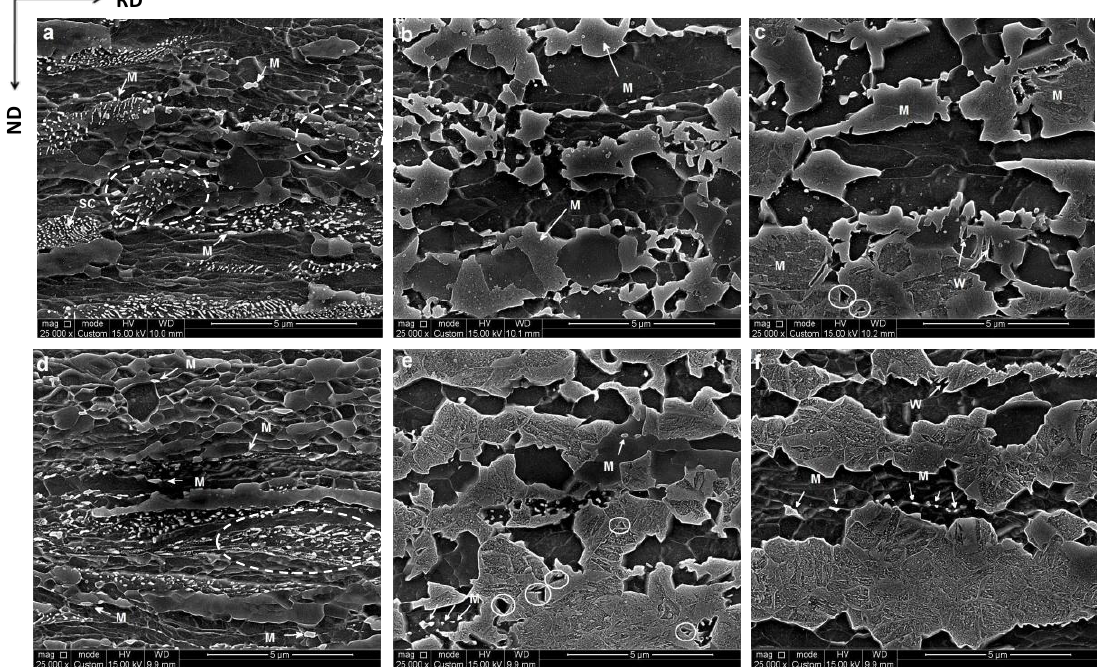
Figure 1. SEM images of samples heated at 150 °C/s to: 704 °C ( a ), 782 °C ( b ), and 838 °C ( c ); and at 1500 °C/s to: 749 °C ( d ), 842 °C ( e ), and 862 °C ( f ). Arrows point to martensite (M), spheroidized cementite (SC), and Widmanstätten ferrite (W). Scale bar for all images is 5 µm.